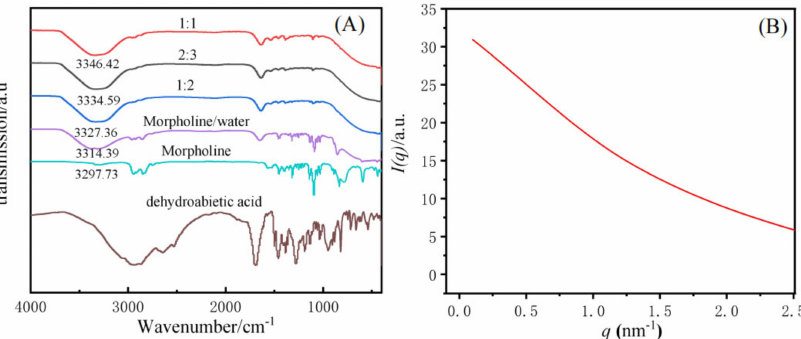
Figure 6. FT − IR picture of different molar ratio of the supramolecular hydrogels ( A ), SAXS spectrum of a 2:3 system of dehydroabietic acid–morpholine at 25 ◦ C ( B ). SAXS was used to study the microscopic morphology of supramolecular